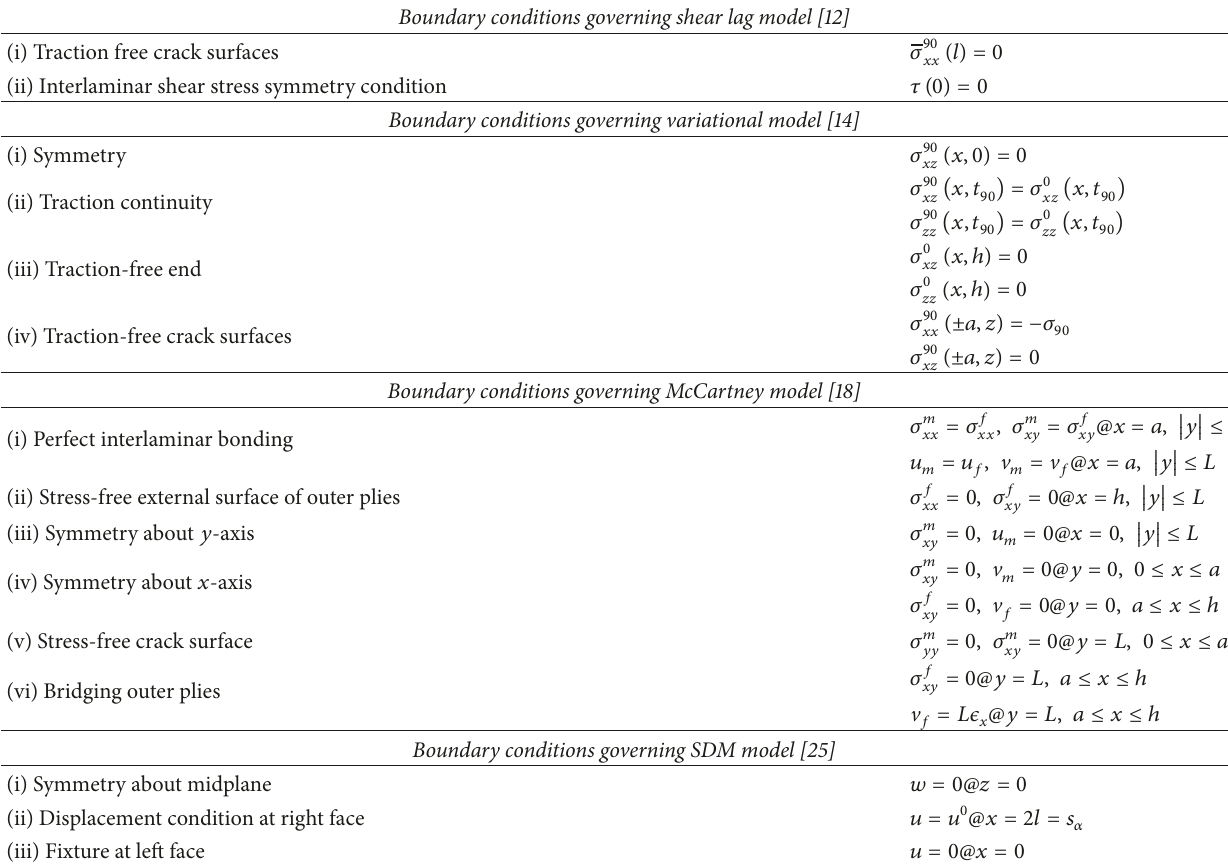
Table 1: Comparison of boundary conditions of the four models analyzed in the present